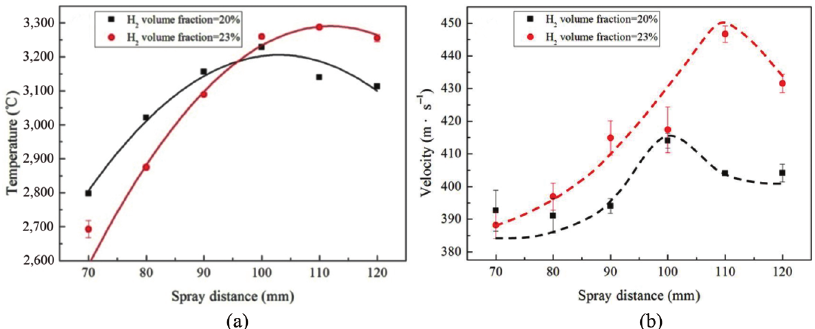
Figure 13: Effects of spraying distance on (a) particles surface temperature and (b) flight velocity with the H 2 volume fraction of 20 and 23%, total Ar þ H 2 gas flow rate of 80 slpm, current of 420 A and power of 65 KW.